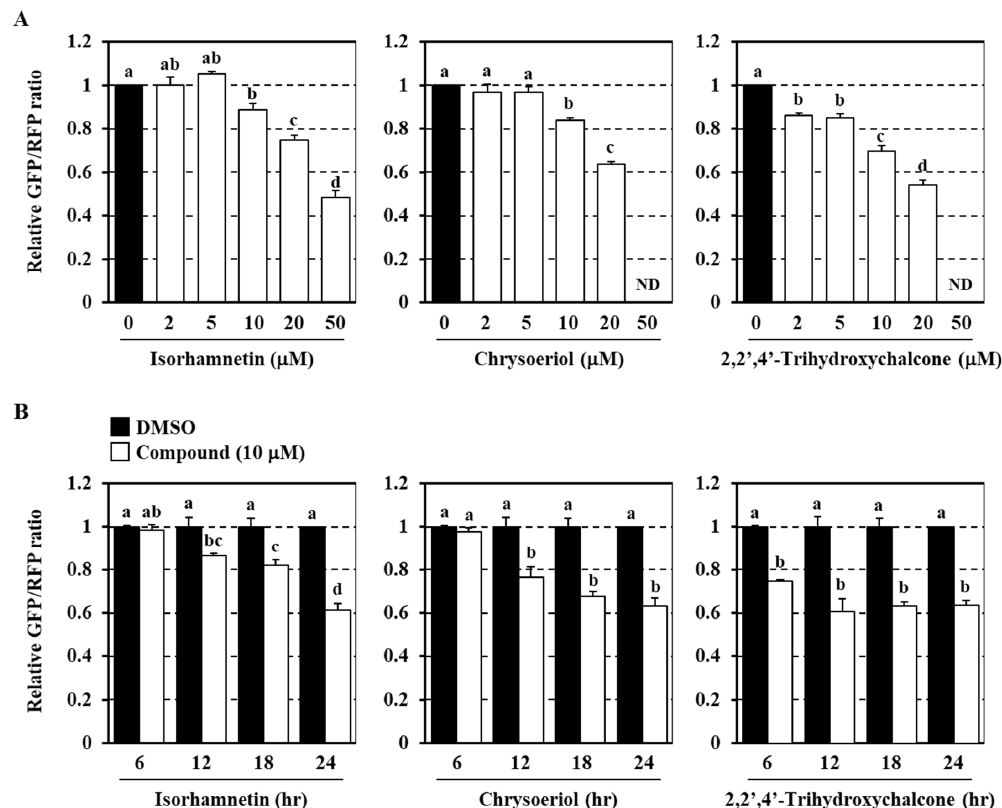
Figure 2. Four dietary phytochemicals, identified using the screening assay, that enhance the autophagy flux. Co-cultured transgenic and wild-type HeLa cells were treated with each phytochemical (10 µM), Torin1 (250 nM), or bafilomycin A1 (100 nM) for 12 h. The cells were then visualized using an Operetta high-content imaging system at 40× magnification to obtain GFP/RFP ratios (n = 2) (– O –G, – O glucoside; – O –GA, – O– glucuronide) ( A ). The chemical structures of phytochemicals enhancing the autophagy flux are shown ( B ).